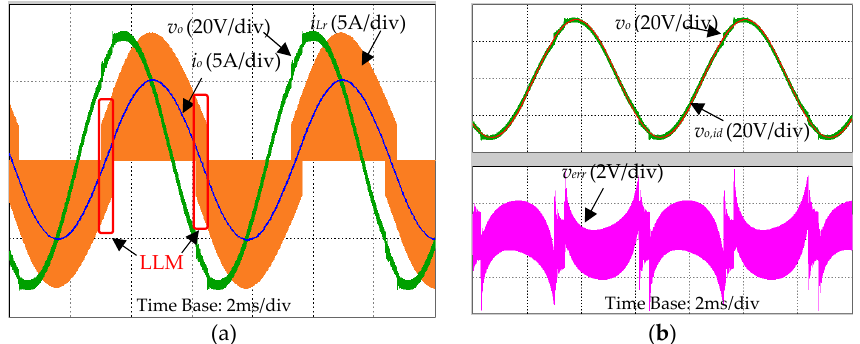
Figure 13. Simulation waveforms of ARSI without dead ‐ time compensation when the modulation index is 0.4 in an open ‐ loop configuration. ( a ) simulation results; ( b ) voltage error.